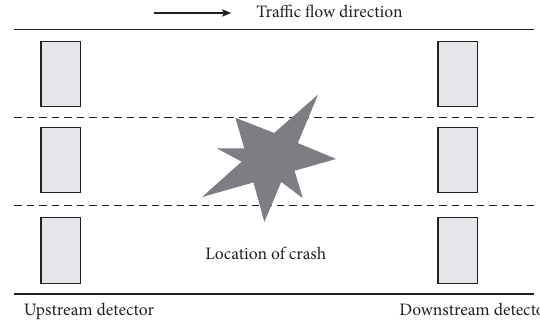
Figure 2: Traffic crash